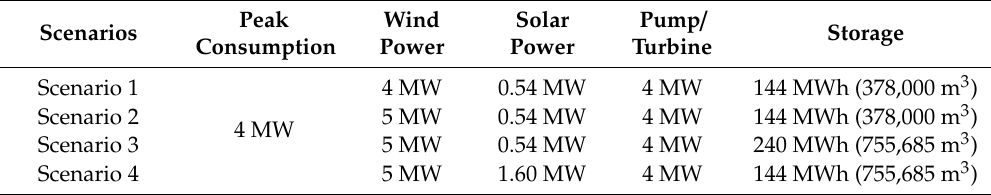
Table 4. Selected